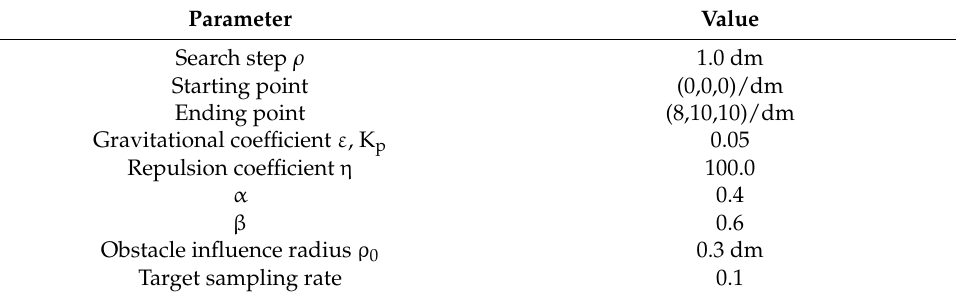
Table 1. Manipulator motion control parameter